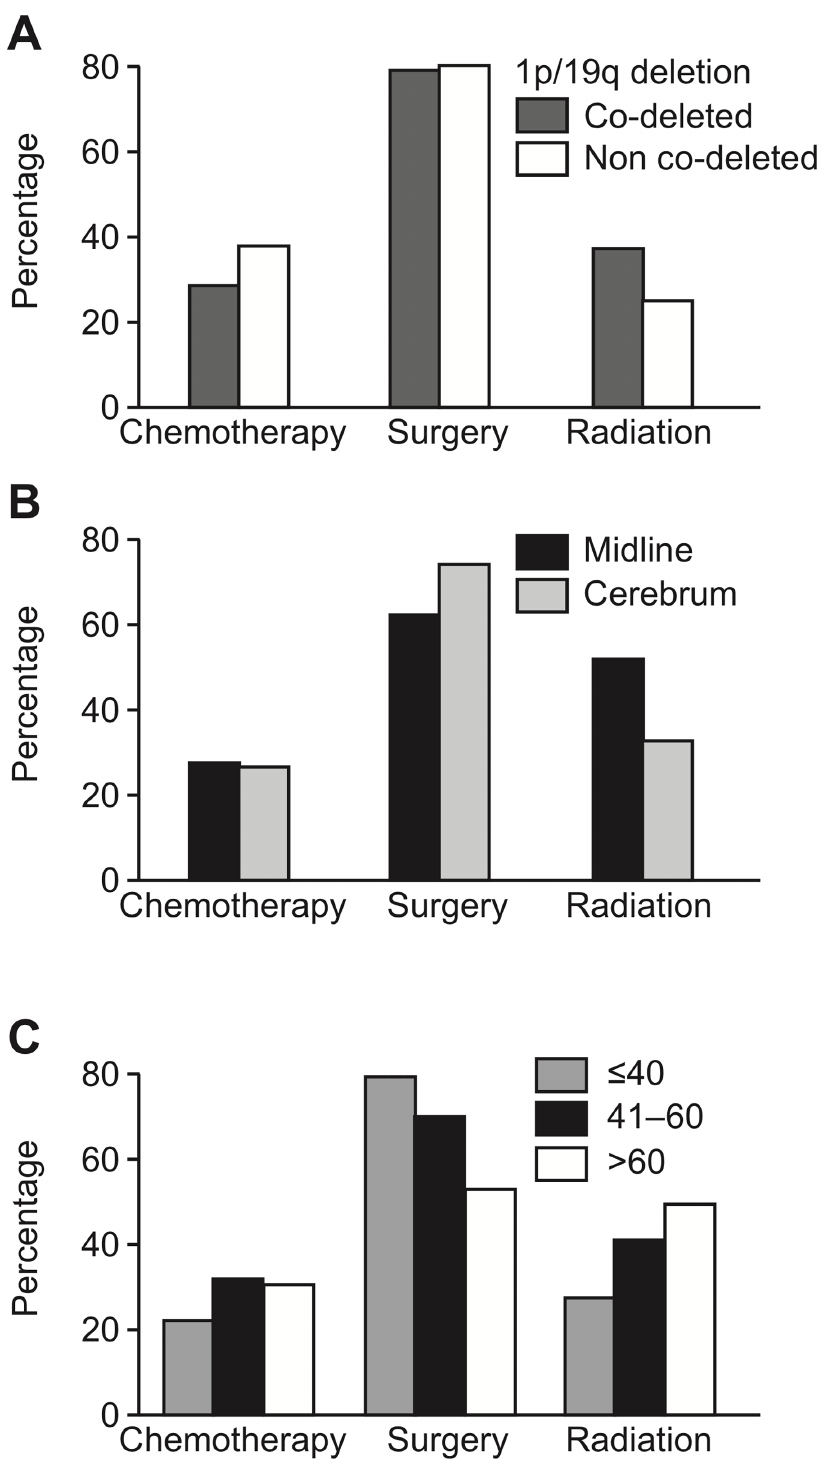
Fig 1. A. Chemotherapy, surgery, and radiation treatment receipt by 1p/19q co-deletion status. B. Chemotherapy, surgery, and radiation treatment receipt by tumor location. C. Chemotherapy, surgery, and radiation treatment receipt by